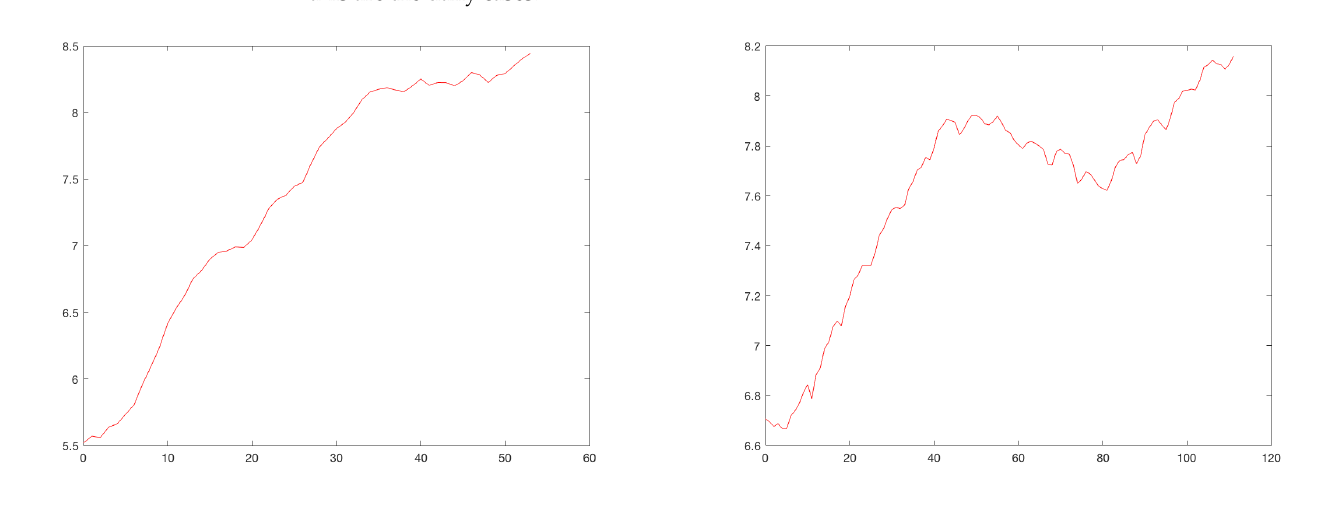
Figure A27. Chile Metropolitan Region’s rises. Horizontal axis, days; vertical axis: logarithm of daily